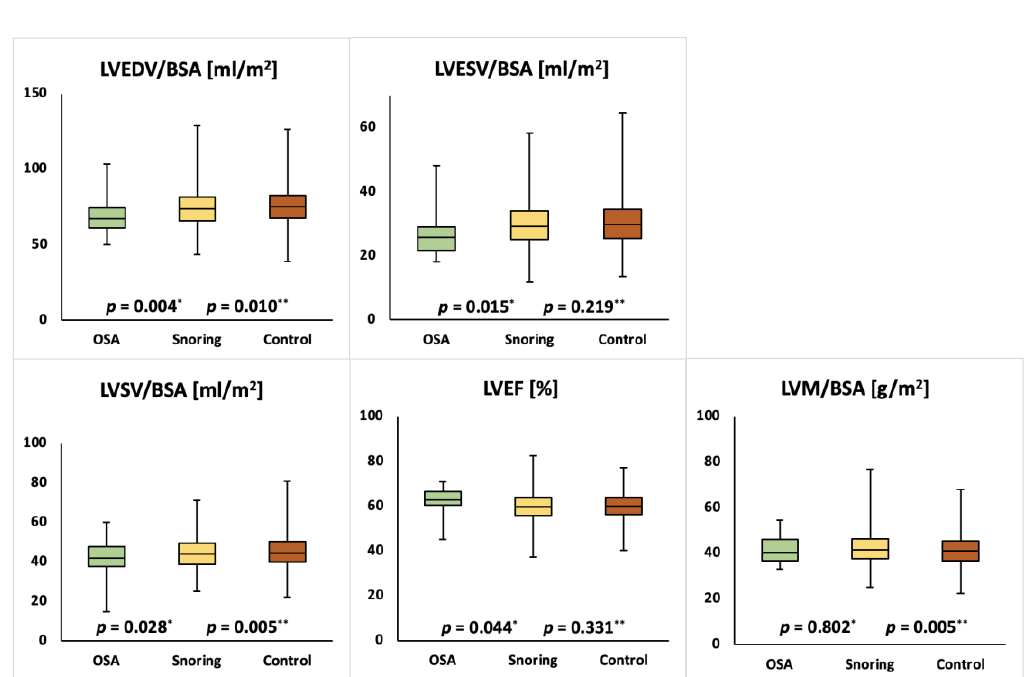
Figure 2. Comparison of left ventricular ejection fraction (LVEF) and end-diastolic volume index (LVEDVI), end-systolic volume index (LVESVI), stroke volume index (LVSVI) and mass index (LVMI) in female individuals with obstructive sleep apnea (OSA), snoring or none of the above. p -values for OSA vs. unaffected (*) and snoring vs. unaffected (**) are reported.